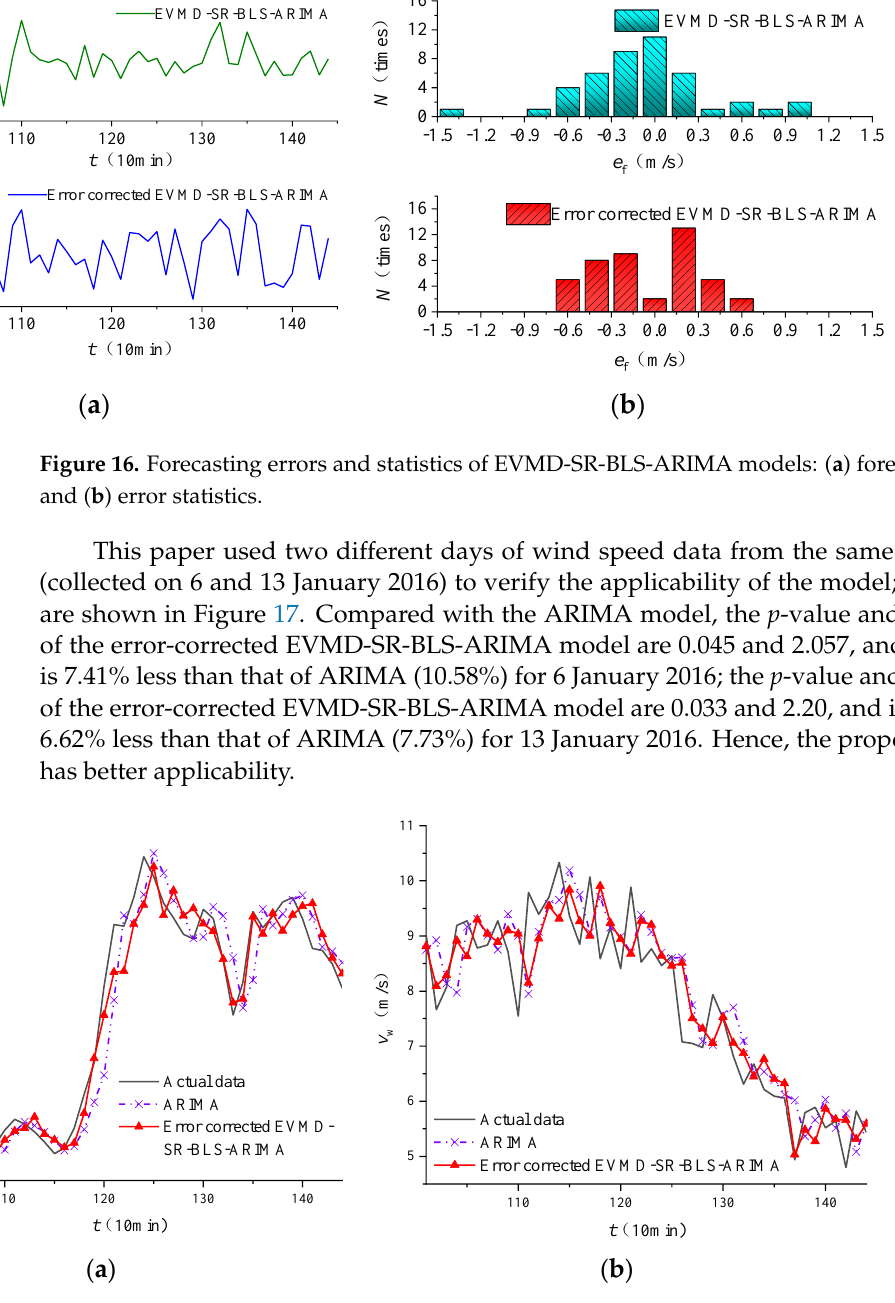
Figure 17. Wind speed forecasting results at different times: ( a ) 6 January 2016 and ( b ) 13 January 2016.